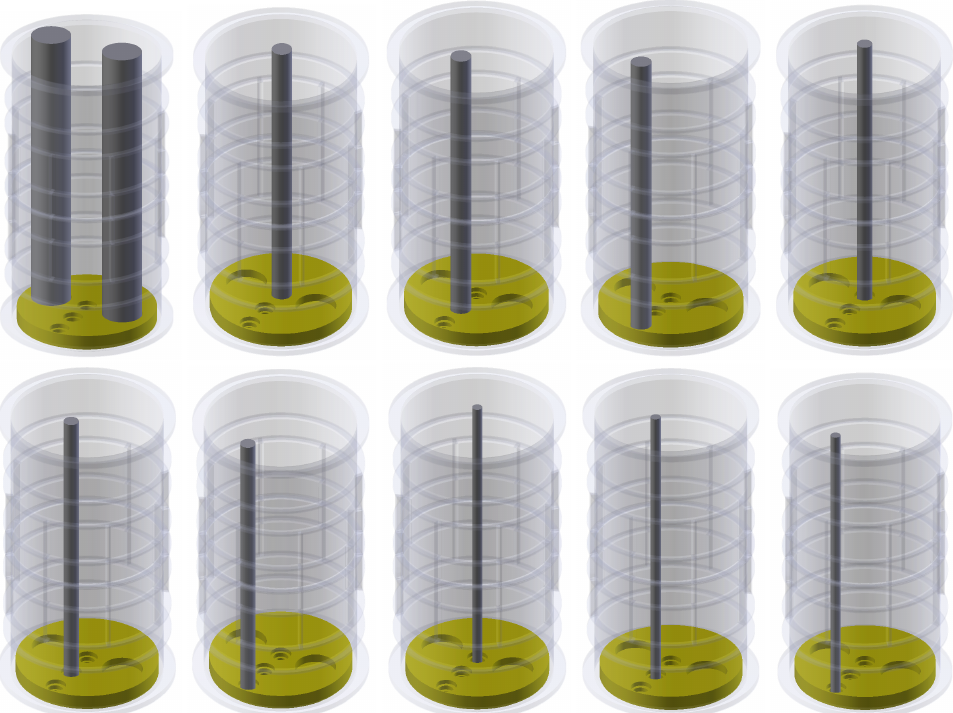
Figure 7. A set of ten phantoms used during high-contrast media measurements tests. The mounting stand had 5 holes. Three 10 mm of diameter holes were positioned along the sensor profile diameter at given positions: “P1” at x = 70 mm, y = 70 mm; “P2” at x = 70 mm, y = 40 mm; “P3” at x = 70 mm, y = 10 mm. Two additional 40 mm of diameter holes were positioned symmetrically at x1 = 110 mm and x2 = 40 mm for y = 70 mm. All the rods were parallel to sensor walls.